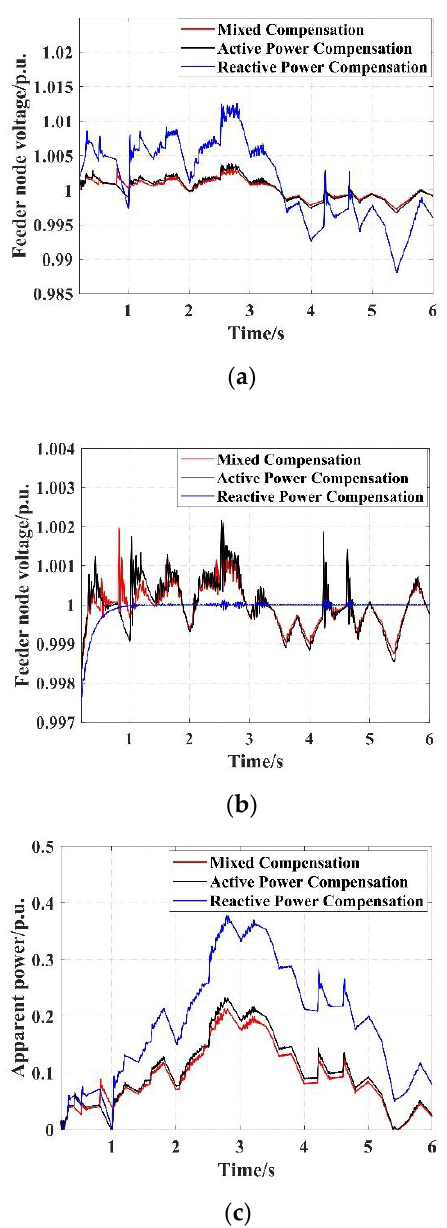
Figure 11. Effect of different compensation modes for SOP: ( a ) Voltage at the end of feeder 1; ( b ) Figure 11. E ff ect of di ff erent compensation modes for SOP: ( a ) Voltage at the end of feeder 1; ( b ) Voltage Voltage at the end of feeder 2; ( c ) Apparent power consumption. at the end of feeder 2; ( c ) Apparent power